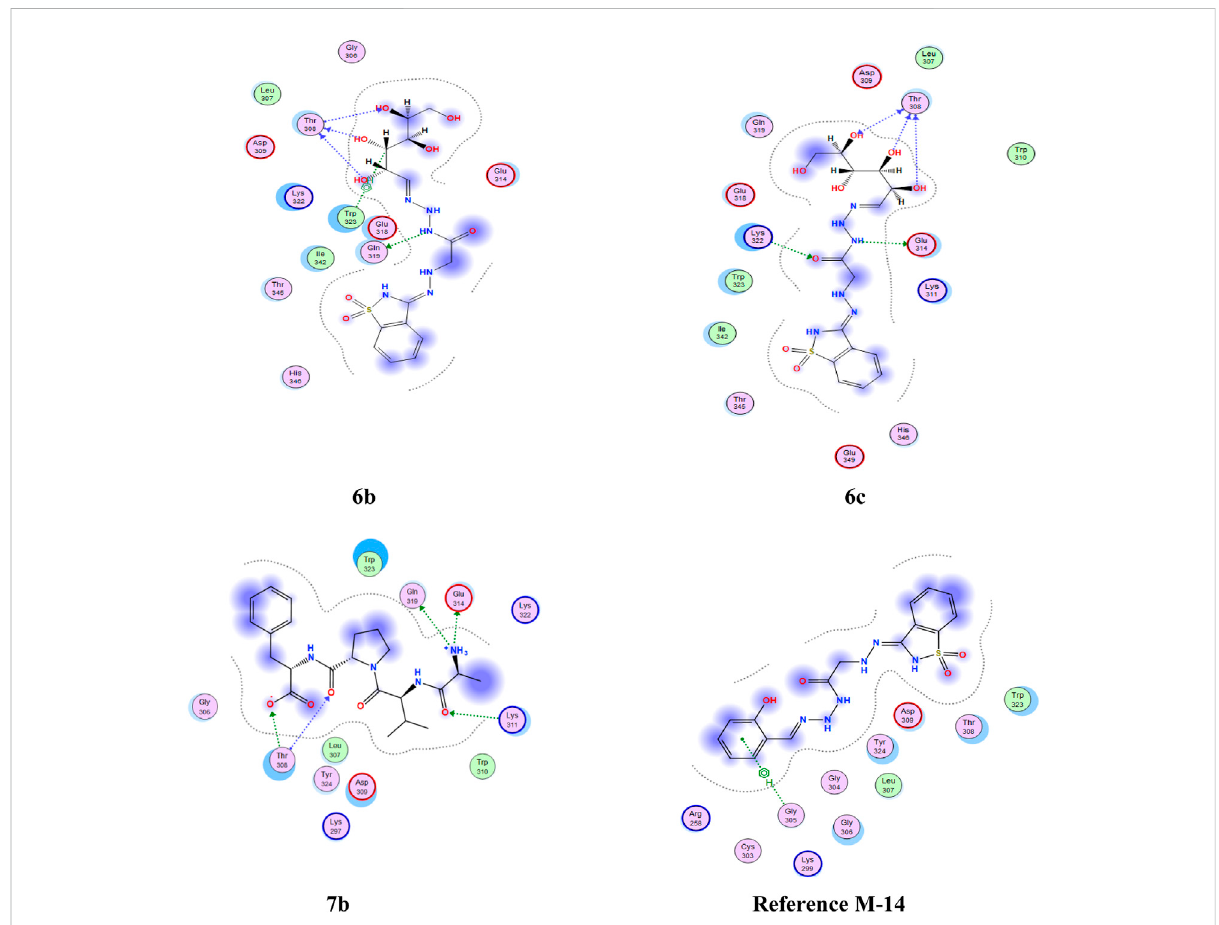
FIGURE 4 2D interaction of higher, lower, and reference compounds with 2OPZ ’ melanoma cancer protein.